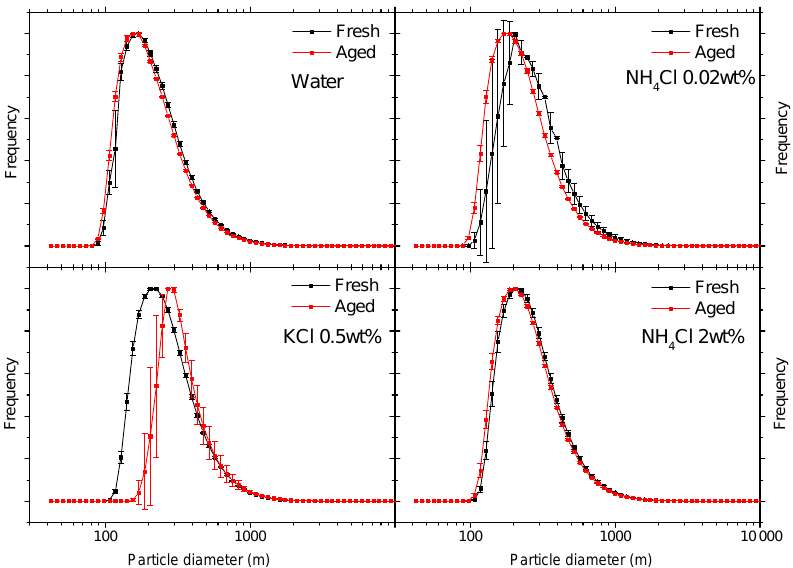
Figure B1. Particle size distributions obtained from the laser diffraction particle size analyzer (Beckman Coulter LS13 320) for fresh (black squares connected with line) and aged suspensions (red squares connected with line) of 2wt% microcline in pure water, 0.5wt% KCl, 0.02wt% NH 4 Cl and 2wt% NH 4 Cl. Size distribution measurements of each suspension were done in triplicates and each solid square shows the mean and one standard deviation as error bars. The aging period was 2h (roughly typical emulsion freezing measurement time span with